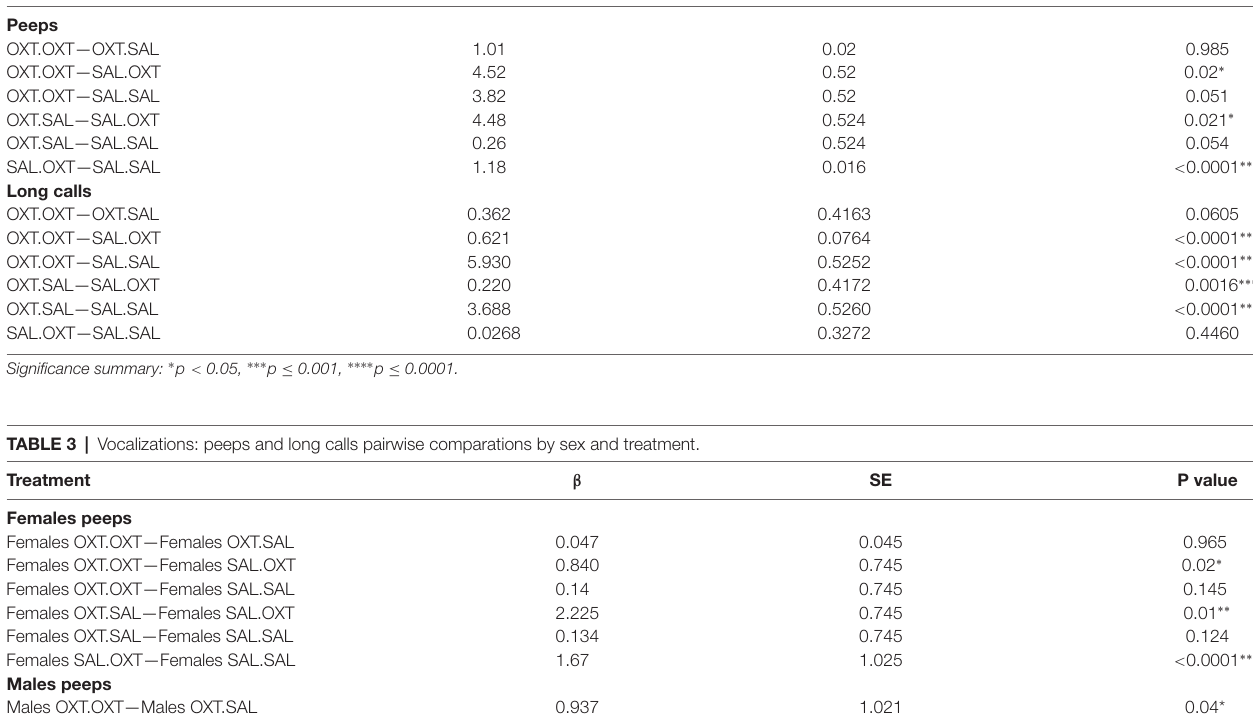
TABLE 2 | Vocalizations. Peeps (number) and long call (duration) comparations by treatment. Treatment β SE